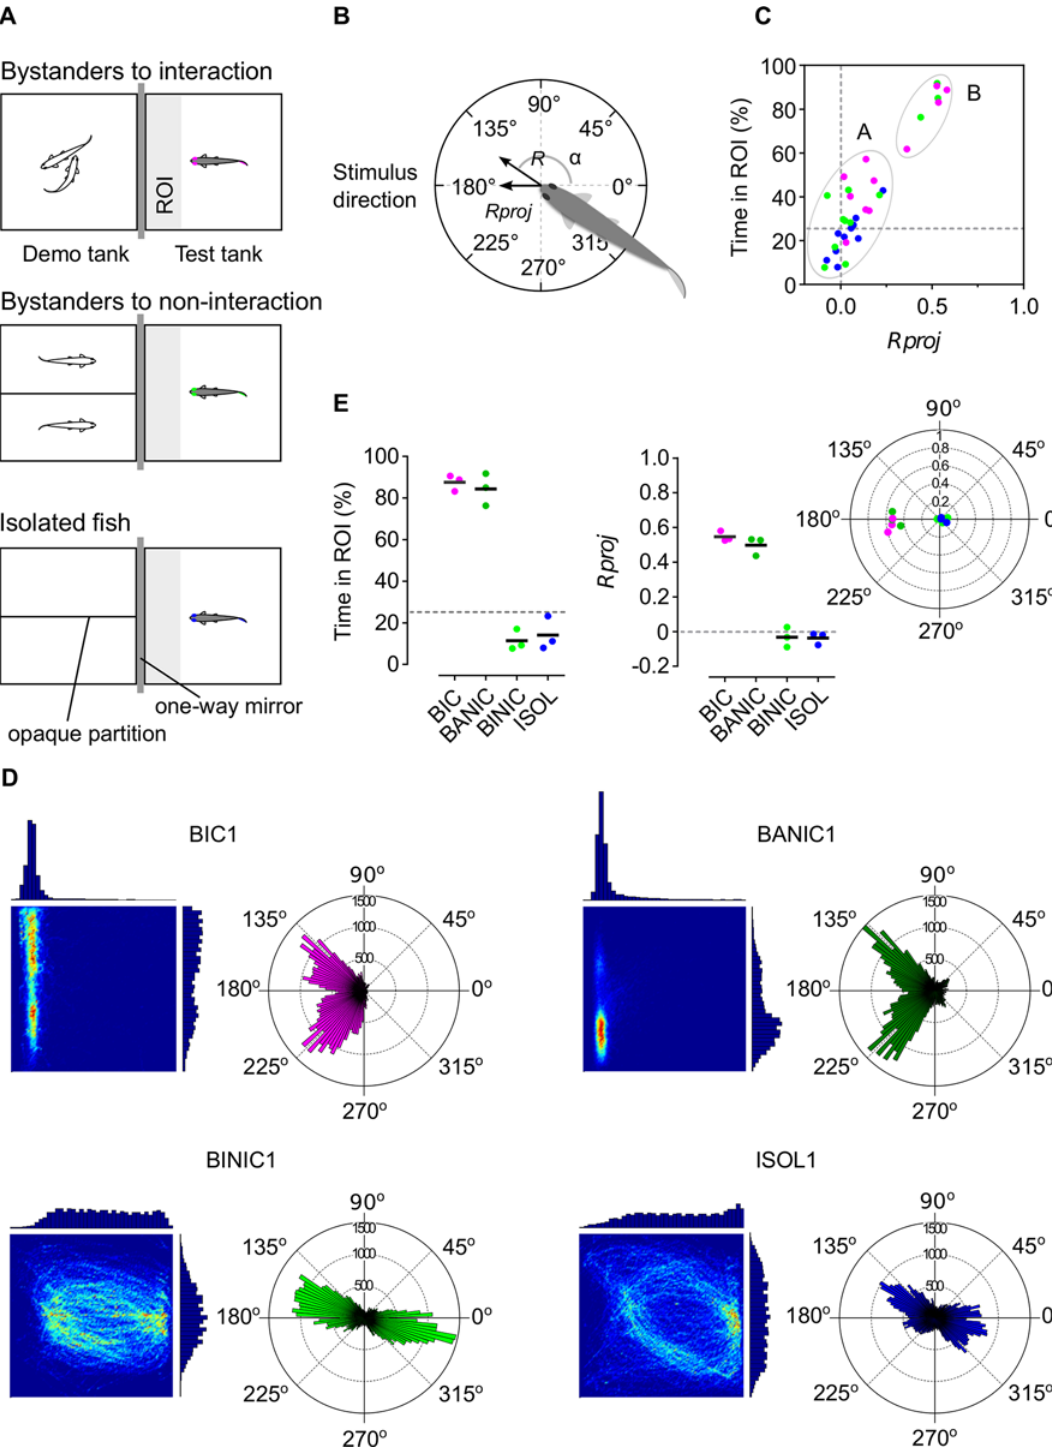
Fig 1. Behavioral paradigm and selected behavioral groups for transcriptomic analysis. (A) Schematics of experimental treatments bystanders to interacting conspecifics (magenta), bystanders to non-interacting conspecifics (lime); and isolated fish (blue). ROI in light grey. (B) Schematic of the subject fish ’ s mean resultant directional vector composed by the vector ’ s length R , mean angle α (0° opposite and 180° directed towards the stimulus) and R projected onto 180° ( Rproj ). (C) Clustering analysis of all focal fish from the experimental treatments using time spent in ROI and Rproj . Cluster A – strongly attentive profile; cluster B – weakly attentive profile. (D) Linear histograms and 2D heatmaps of time spent in each position of the arena (left), and polar